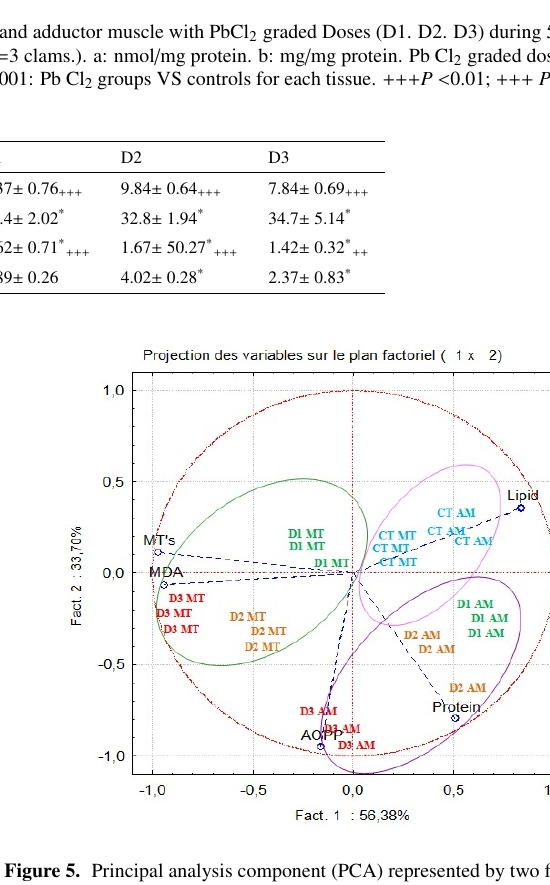
Figure 5. Principal analysis component (PCA) represented by two factors F1 and F2 and produced by biochemical variables in control and stultorum mantle and adductor muscles with Pb Cl 2 graded doses (D1, D2, D3) during 5 days. Projection of the variables and the cases on the factor-plane (1 × 2); D1:1mg / L PbCl 2 ; D2:2.5mg / L PbCl 2 ; D3:5mg / L PbCl 2 ; MT: mantle; AM: adductor